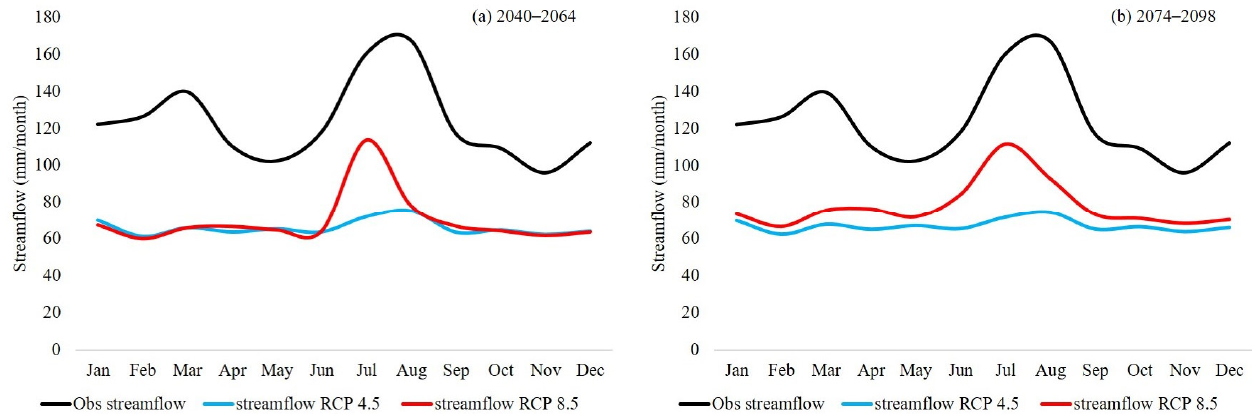
Figure 7. Average monthly streamflow, as projected using the 5 best performing NEX-GDDP models under the RCP 4.5 and 8.5 (blue and red lines, respectively) to force the HBV-light model over Chirah sub catchment for ( a ) 2040–2064 and ( b ) 2074–2098. For comparison purposes, the corresponding historical values are also given in black.